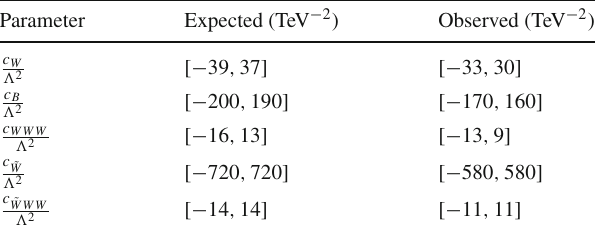
Table 10 Expected and observed 95% C.L. intervals for individual EFT coefficients divided by the square of the new physics scale (cid:19) , with other coefficients set to zero. Intervals are calculated using the high- q 2 region yields (Table 4)